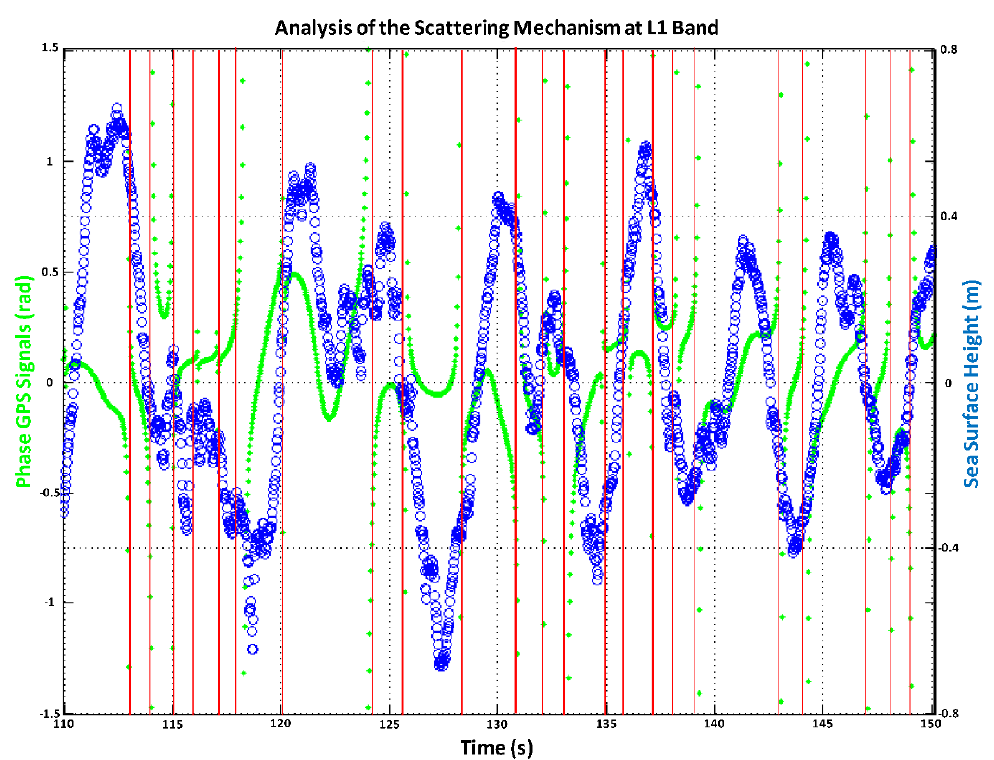
Figure 7. Analysis of the electromagnetic interaction of the GPS signals and the scattering surface in a bistatic scenario. The phase (after retracking) distribution of the scattered field is time- and space-located over the temporal evolution of the SSH as measured by the PYCARO reflectometer. This analysis has been performed with a SWH = 36 cm and an elevation angle of θ = e